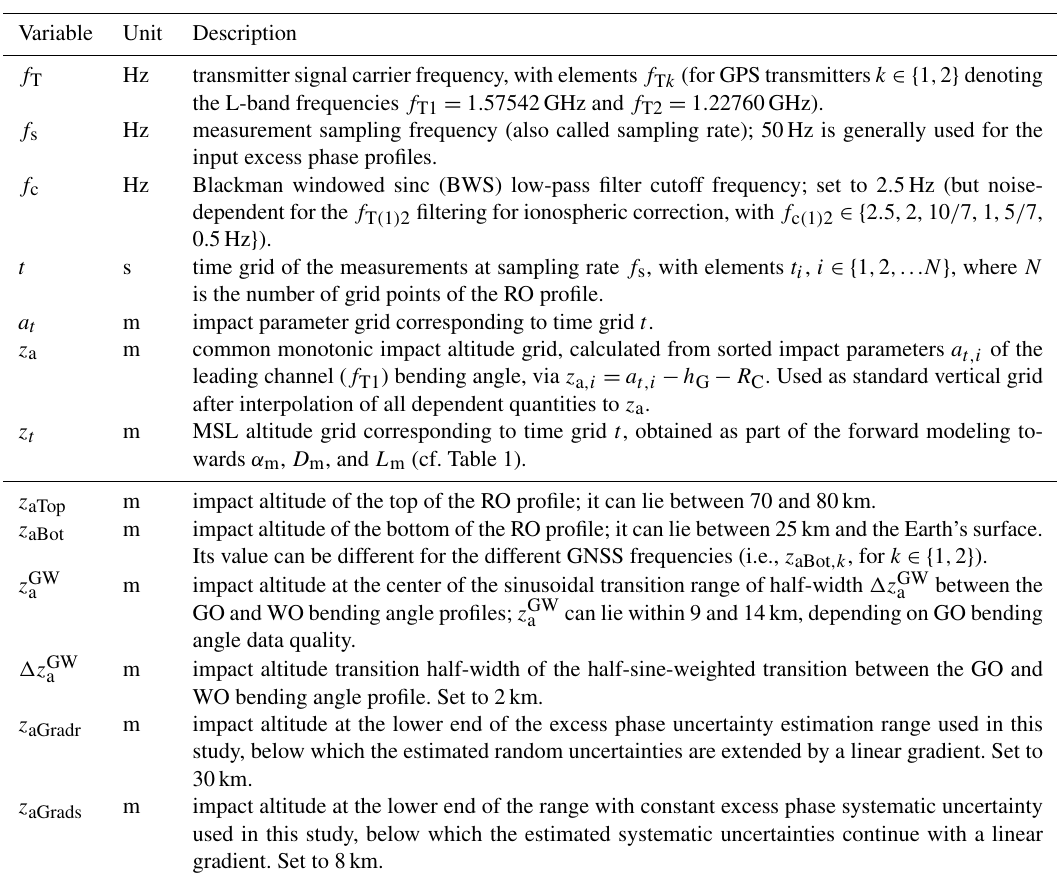
Table 2. Vertical grids, coordinate variables, and specific settings for the rOPS L1b processing system. Variable Unit